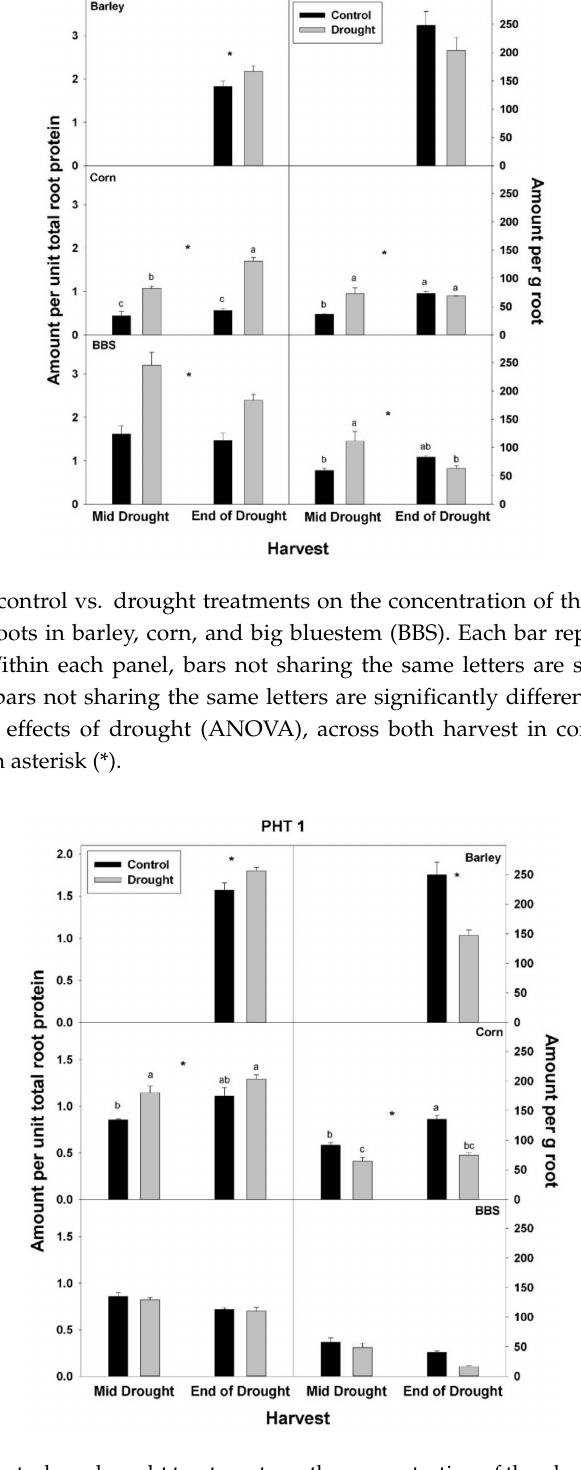
Figure 7. Effects of control vs. drought treatments on the concentration of the phosphate-uptake protein, PHT1, of roots in barley, corn, and big bluestem (BBS). Each bar represents mean + 1 SE (standard error). Within each panel, bars not sharing the same letters are significantly different. For each response variable, significant effects of drought (ANOVA), across both harvest in corn and big bluestem, are indicated with an asterisk